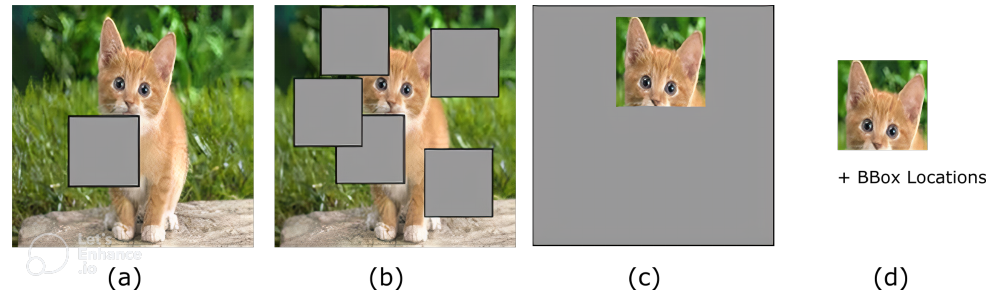
Figure 3. Cutout-based algorithms, including ( a ) vanilla cutout, ( b ) multistep cutout with n = 5, ( c ) in- verse cutout, and ( d ) compressed output of the inverse cutout for the compressed learning